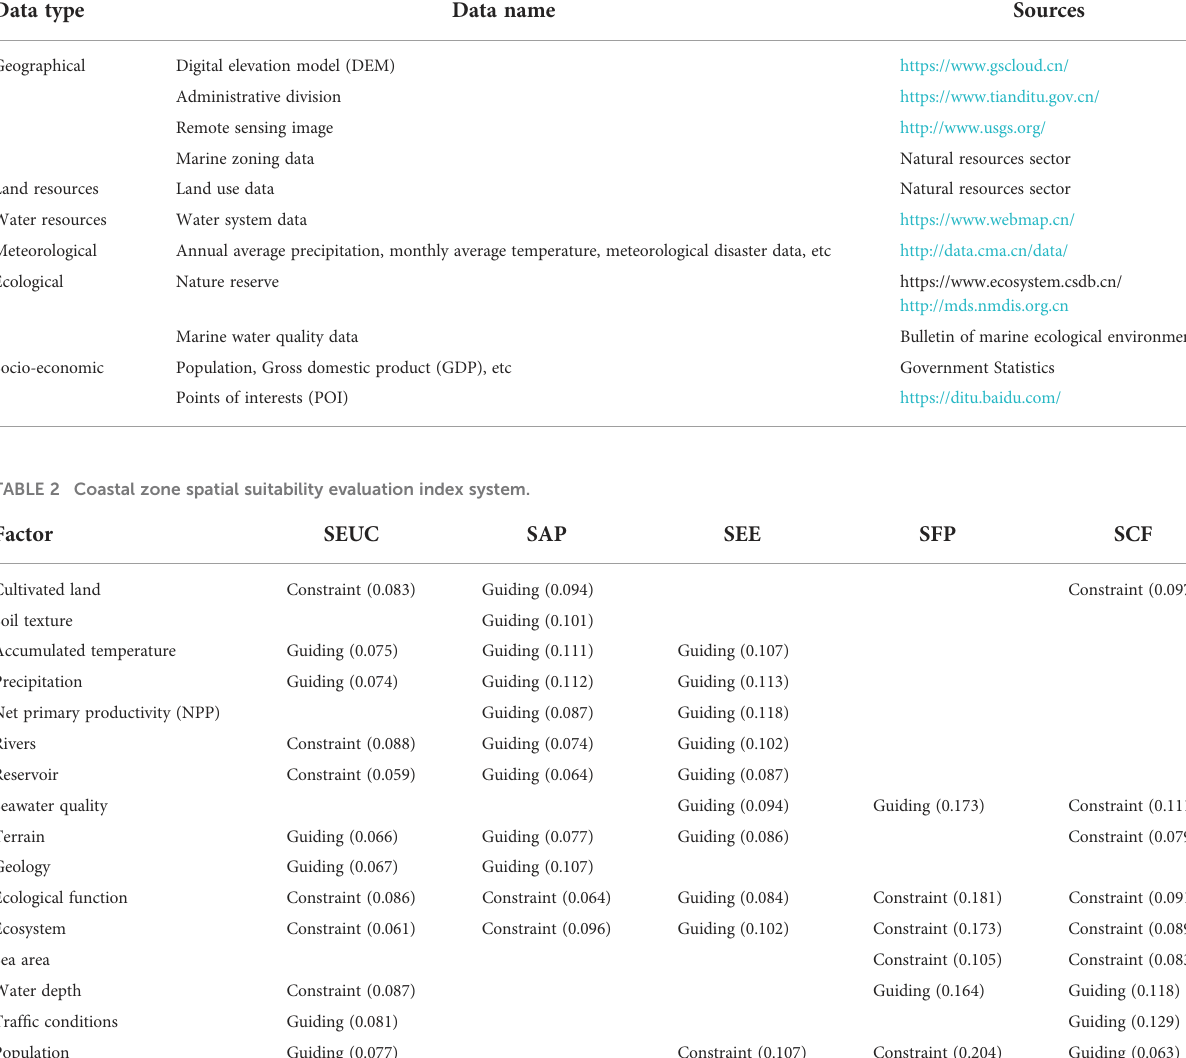
TABLE 1 Data and sources.